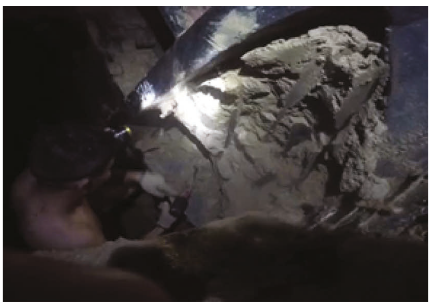
Figure 1: “Mud cake” at cutter head